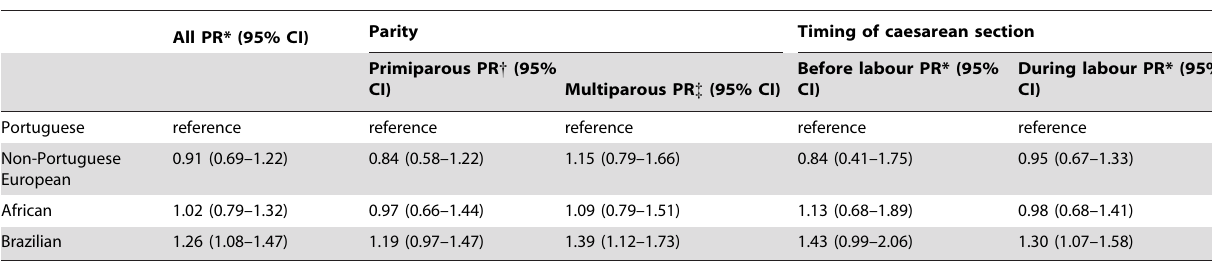
Table 2. Risk of cesarean section and country of birth.